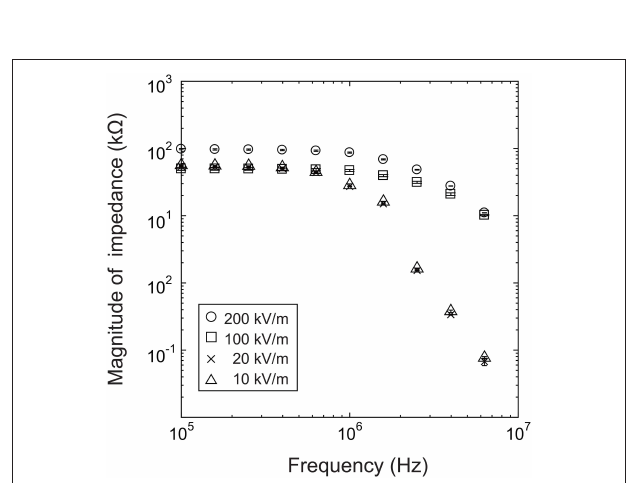
FIGURE 3 | Dependence of impedance response on electric field